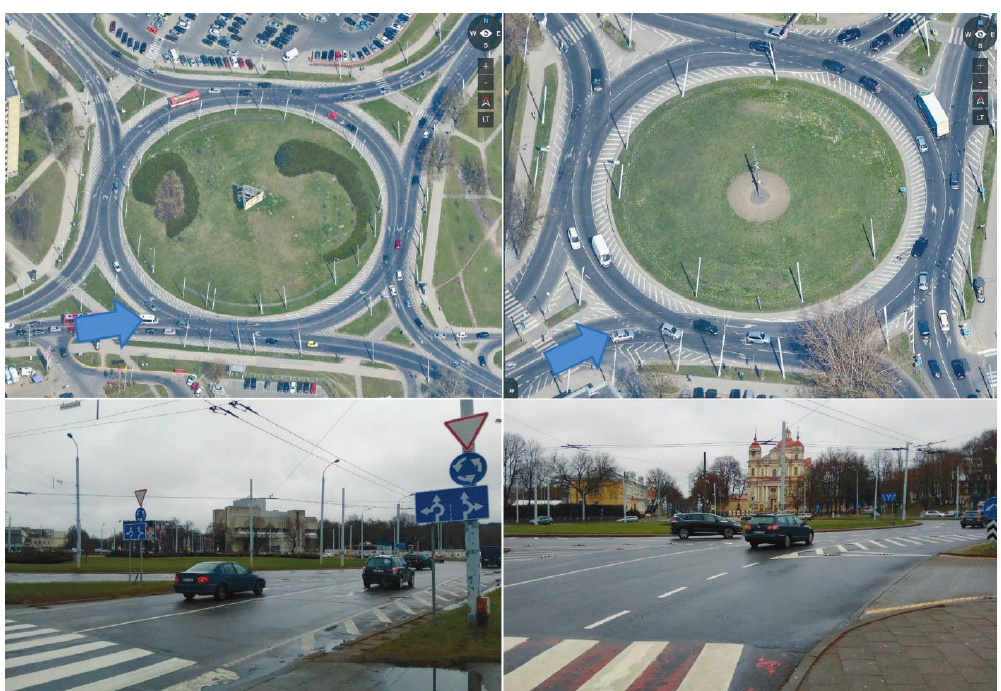
Figure 7. Aerial and local view at roundabouts after traffic reorganisation (arrow in aerial view shows the direction of local view, “Žirmūnai Roundabout” on the left side and “Olandai Roundabout” on the right